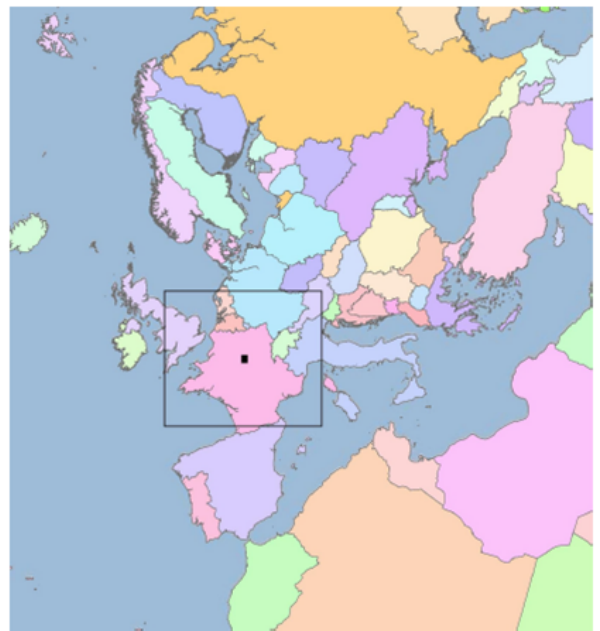
Fig. 1. Definition of different source areas around Paris indicating local Paris emissions (black filled area), 500km from the center of Paris (area inside the black box not including Paris) and >500km (area outside the black box).